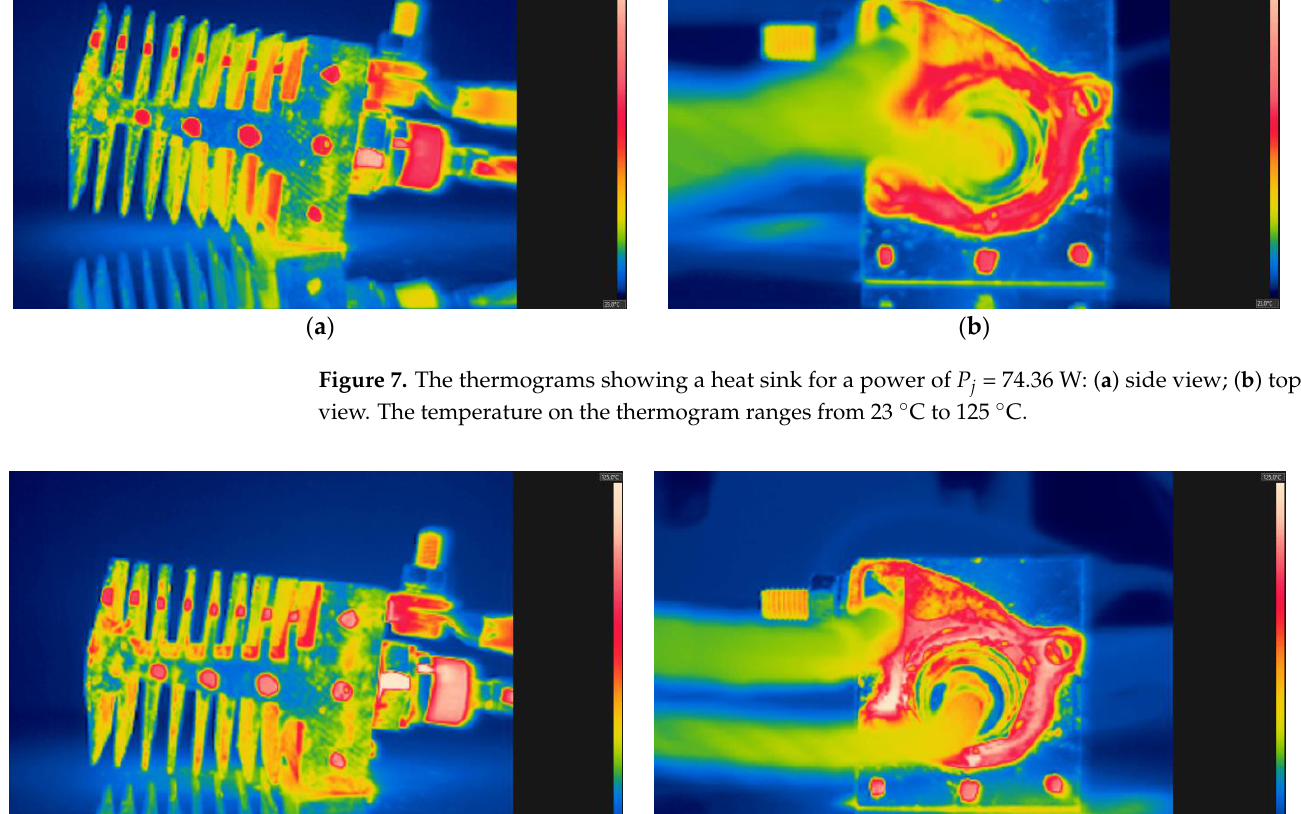
Figure 8. The thermograms showing a heat sink for a power of P j = 117.99 W: ( a ) side view; ( b ) top